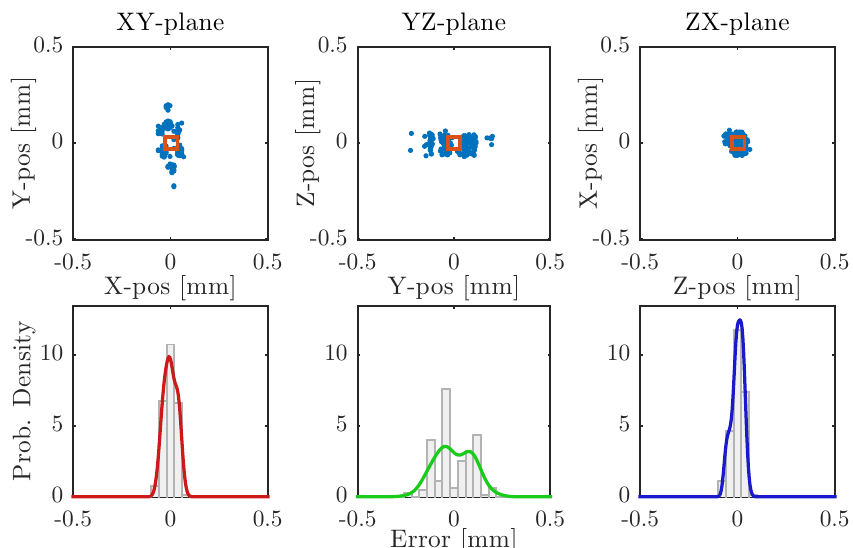
Figure 13. Planar position point-clouds ( top ) and deviation distribution ( bottom ) for 200 measurements of the pipe work-object origo using the tool mounted inductive proximity probe (Sensor C).